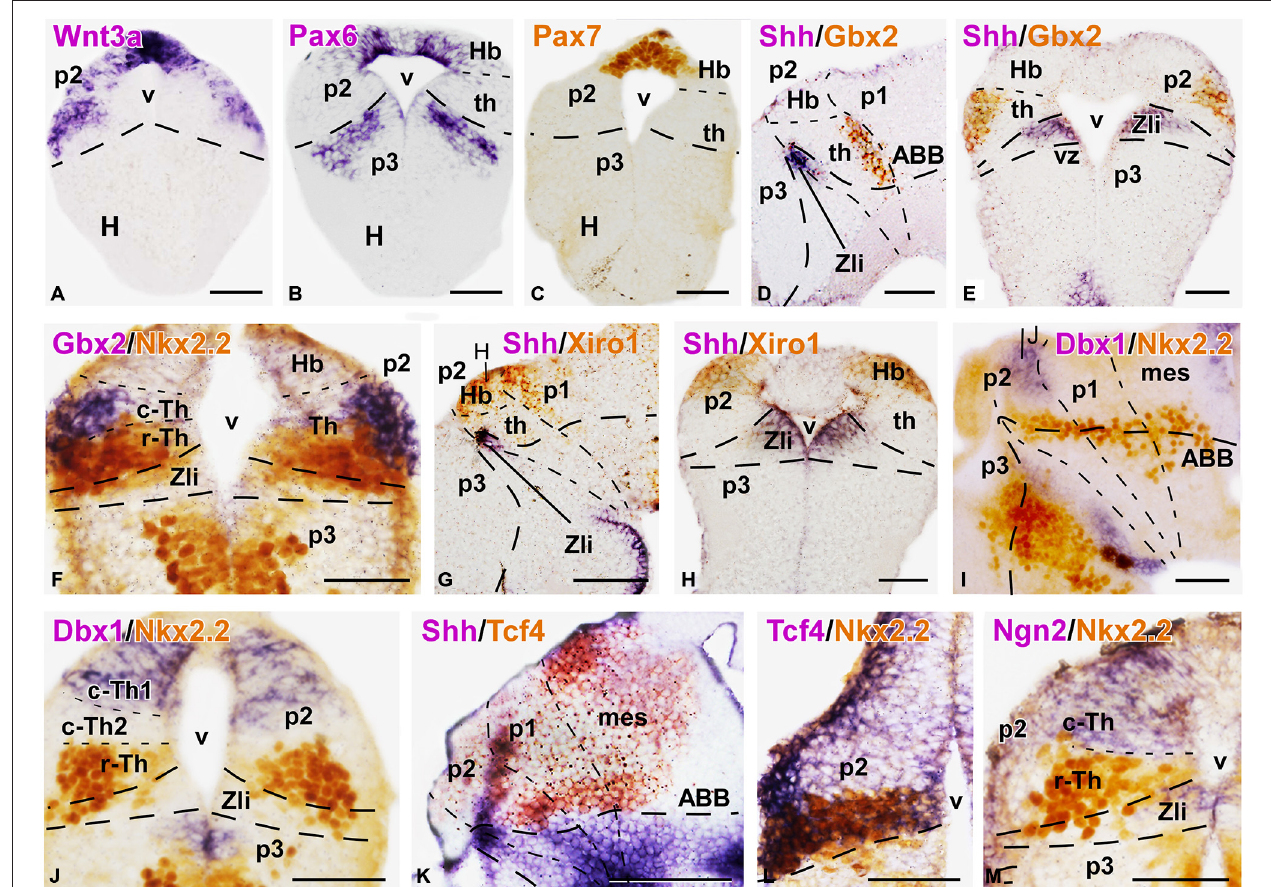
sections, and rostral is to the left in sagittal sections. The neuromeric boundaries and main brain subdivisions are indicated to assist in the precise localization of the labeling. Note the mutually exclusive expression between Gbx2 in the thalamus and the Xiro1 in the habenular region, (compare E and H ; D and G) . The levels of the transverse sections (H,J) are indicated in photographs (G,I) , respectively. Scale bars = 100 µ m (G,K) , 50 µ m (A–F,H,I,K–M) . See list for